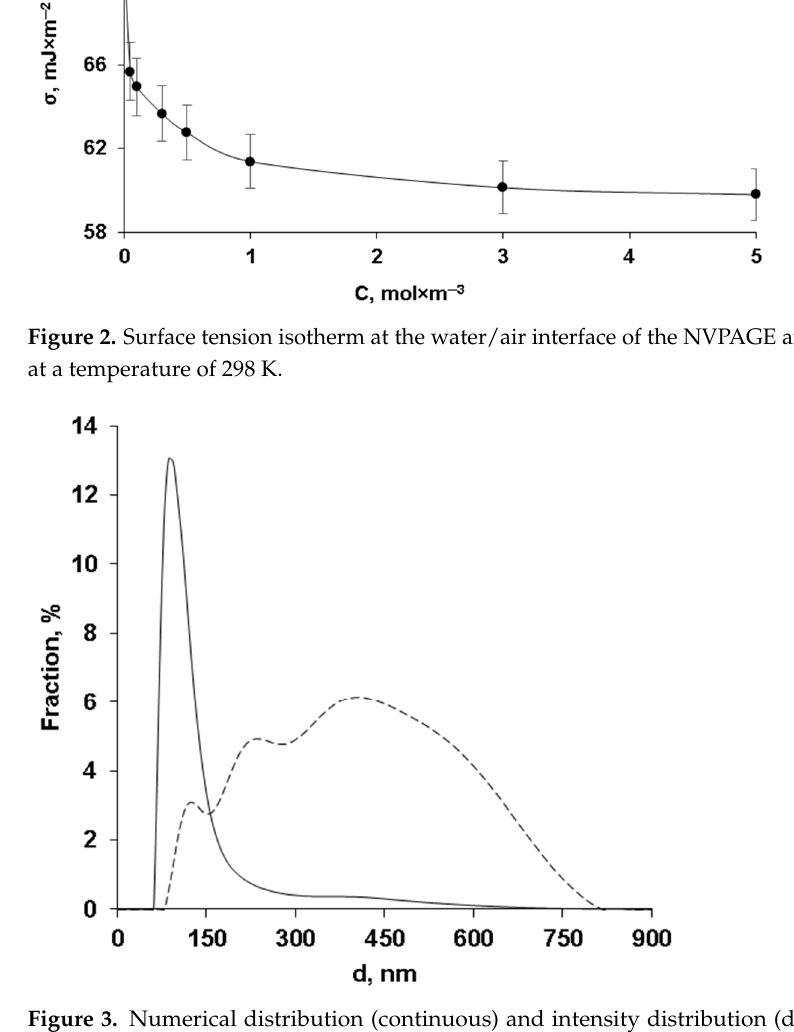
Figure 3. Numerical distribution (continuous) and intensity distribution (dotted line) of particle di- ameters in an aqueous solution of NVPAGE amphiphilic copolymer at a temperature of 298 K.